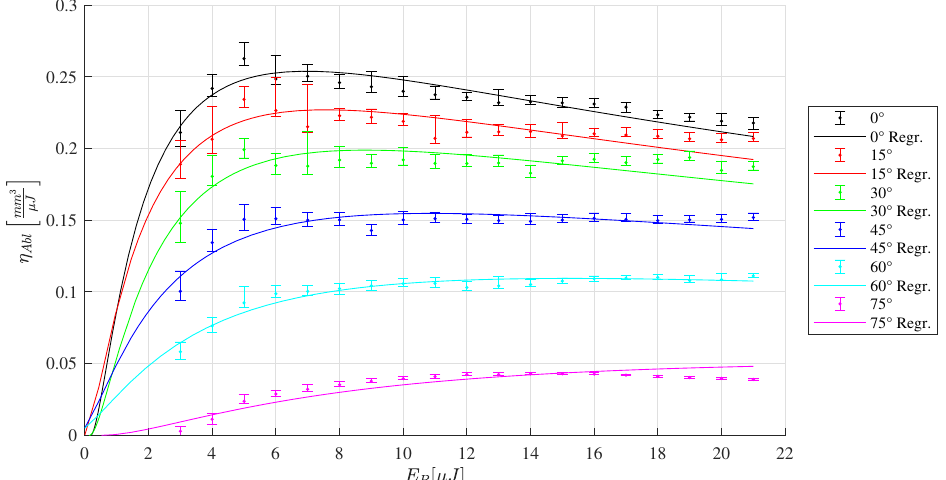
Figure 12. Energy specific ablation volume LST 320 for a range of inclination angles ranging from 0 ◦ to 75 ◦ . The corresponding regression of the ablation model [13] leads to the parameters F th (0 ◦ ) = 0.26Jcm –2 and δ (0 ◦ ) = 139nm.